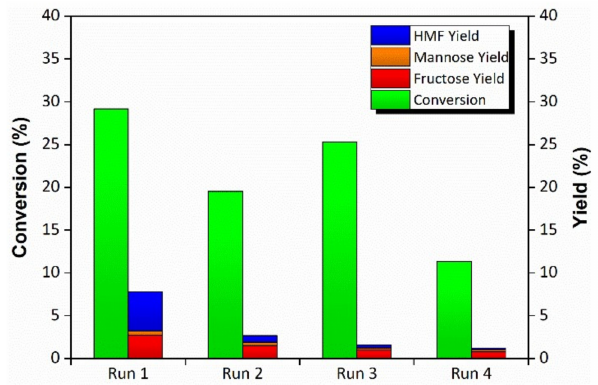
Figure 9. Recyclability of MIL-88B(Fe,Sc) as a catalyst for glucose conversion (120 ◦ C in DMSO for 3